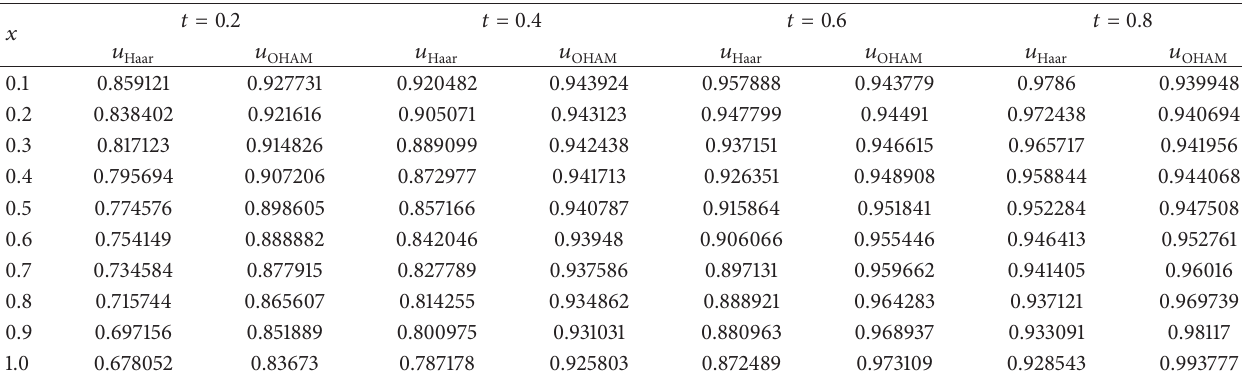
Table 7: The approximate solutions of generalized Fisher equation (49) using Haar wavelet method and five terms for fourth-order OHAM with convergence control parameters 𝐶 1 = −0.5059152 , 𝐶 2 = −0.0211535 , 𝐶 3 = −0.05081612 , and 𝐶 4 = 0.0574318 at various points of 𝑥 and 𝑡 for 𝛼 = 0.5 .